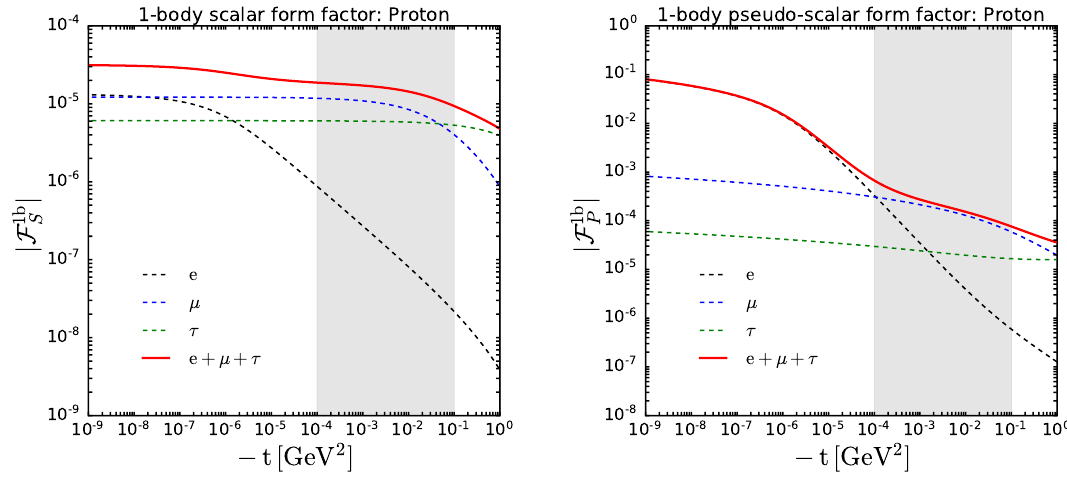
Figure 2. Form factors for one-body interactions of DM with protons, as a function of the square of the exchanged momentum, − t : scalar form factor, F 1b ( t ; m ) (left panel) and pseudo-scalar p , m ‘ S form factor, F 1b ( t ; m ) (right panel). We show the results for interactions with a given lepton p , m ‘ P in the triangle loop: e (black dashed curves), µ (green dashed curves) and τ (blue dashed curves); and for the total contribution (red solid curves). The gray shaded area indicates the range of momentum transfer relevant for scattering of local galactic DM off standard